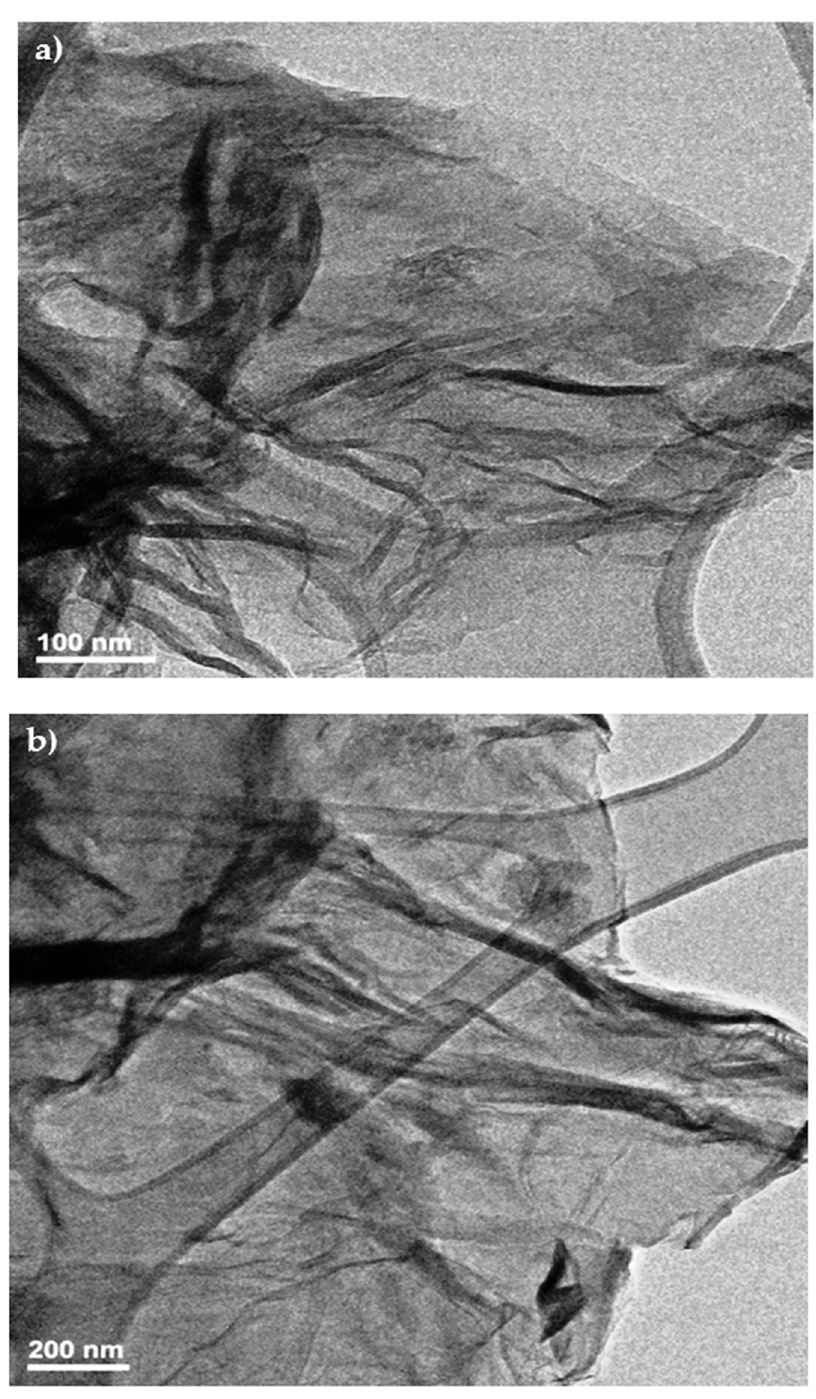
Figure 10. High-resolution TEM microscopy of graphene oxide reduced with natural extracts at ( a ) magnification of 100 nm and ( b ) magnification of 200 nm. ( a ) magnification of 100 nm and ( b ) magnification of 200